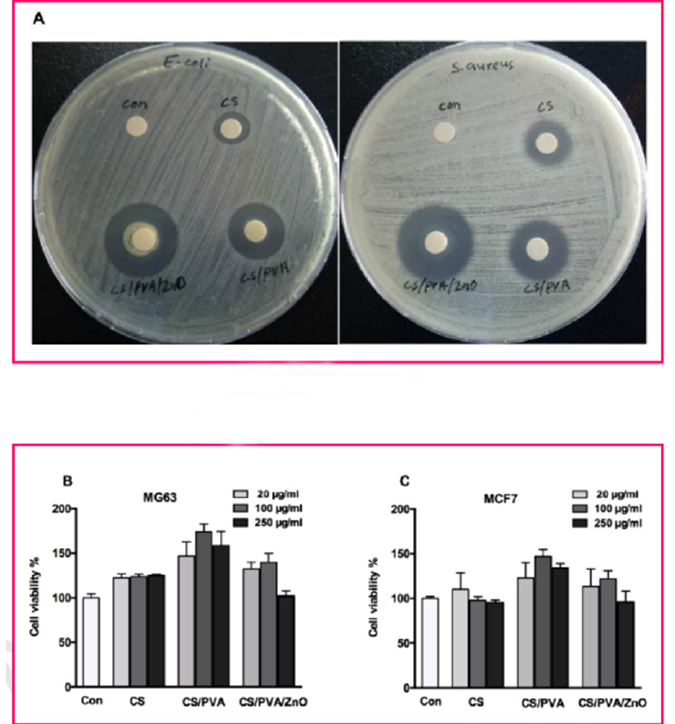
Figure 23. The antibacterial activities of CS, CS/PVA, and CS/PVA/ZnO: ( A ) Diameter of zone of inhibition on E. coli culture (gram negative bacteria); ( B ) Effect of mammalian cell viability of freshly prepared CS, CS/PVA, and CS/PVA/ZnO on MG63 (human osteosarcoma cell line) and ( C ) MCF7 (Human breast cancer cell line) cells. Reprinted/adapted with permission from Ref. [204]. Copyright© 2022, Elsevier B.V.